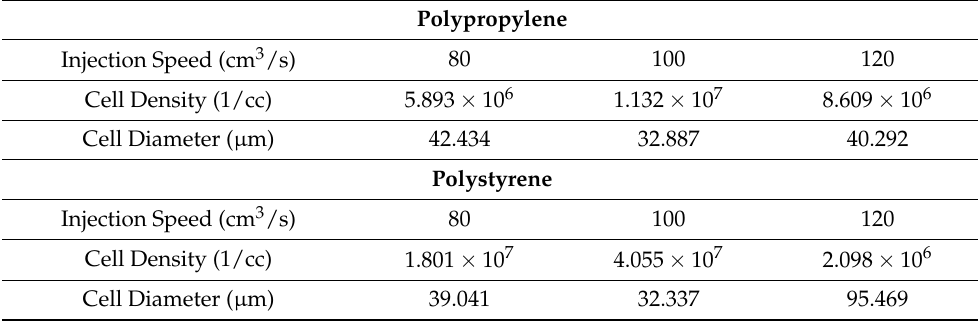
Table 5. Microscopic effects of injection speed on the PP and PS cells as observed through the